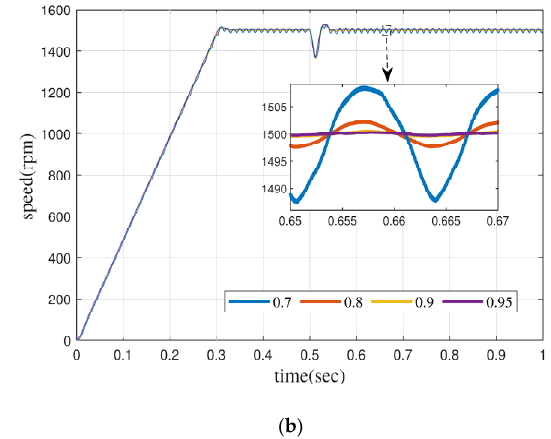
Figure 9 ( a ) Normal PID control+MRAO, ( b ) FOMRAC+MRAO. Figure 9. ( a ) Normal PID control+MRAO, ( b )